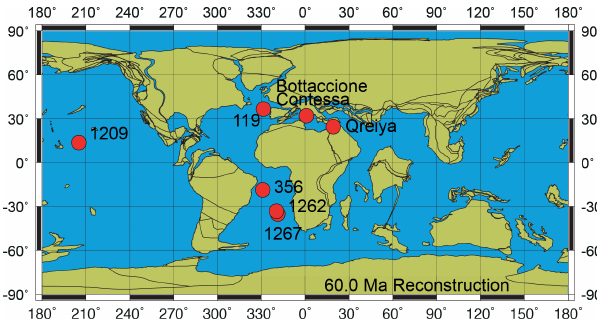
Figure 1. Paleoceanographic reconstruction at 60Ma with the lo- cation of the studied sites and sections (http://www.odsn.de/odsn/ services/paleomap/paleomap.html, last access: 25 February 2021; Hay et al.,